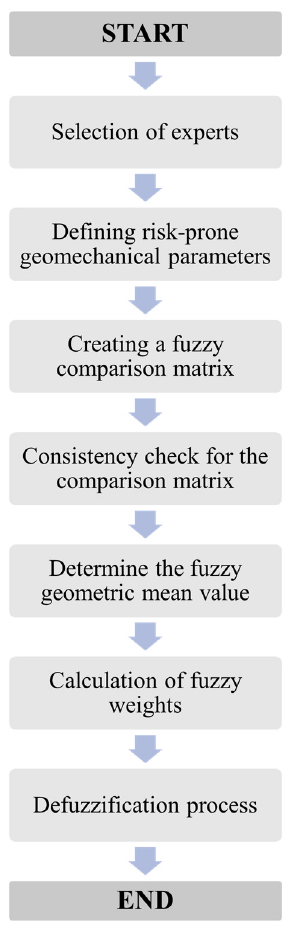
Figure 3. Flow chart of the developed weighting procedure.